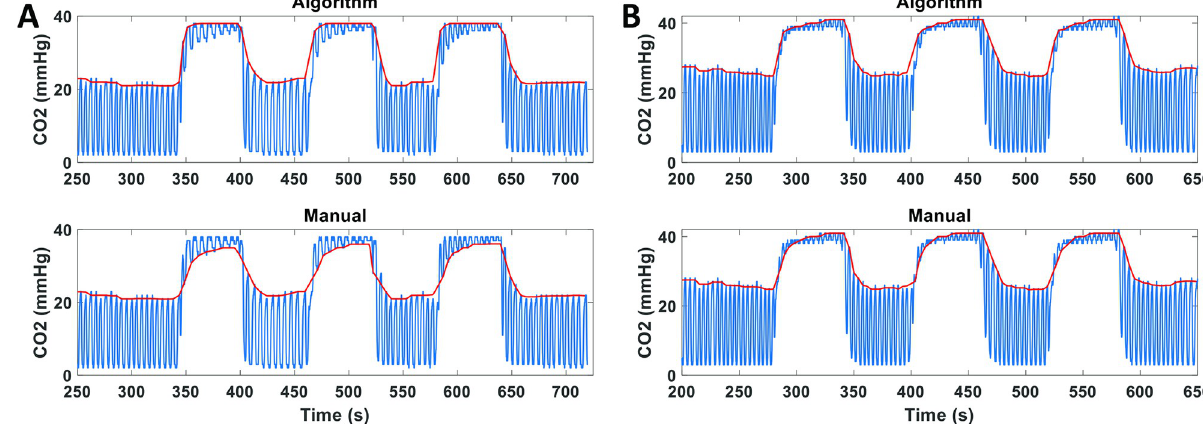
Fig 13. Two examples of “CO2 Switching”. Top panels show the EtCO2 time courses obtained from the automatic CO2 processing algorithm. Bottom panels show the manual and correct EtCO2 time courses.